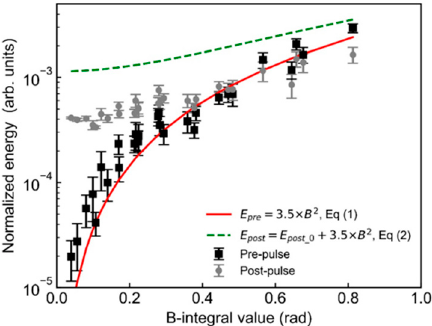
Figure 5. ( a , b ) Temporal contrast for the pre ‐ and post ‐ pulses, and ( c ) normalized energy of pre ‐ and post ‐ pulses when increasing the laser energy of the main pulse from 6.6 to 56 mJ. The experimental condition is shown as No. 4 in Table 1. The solid line indicates the results of the approximate curves with Equation (1). The dashed line indicates the post ‐ pulse energy of Equation (2).